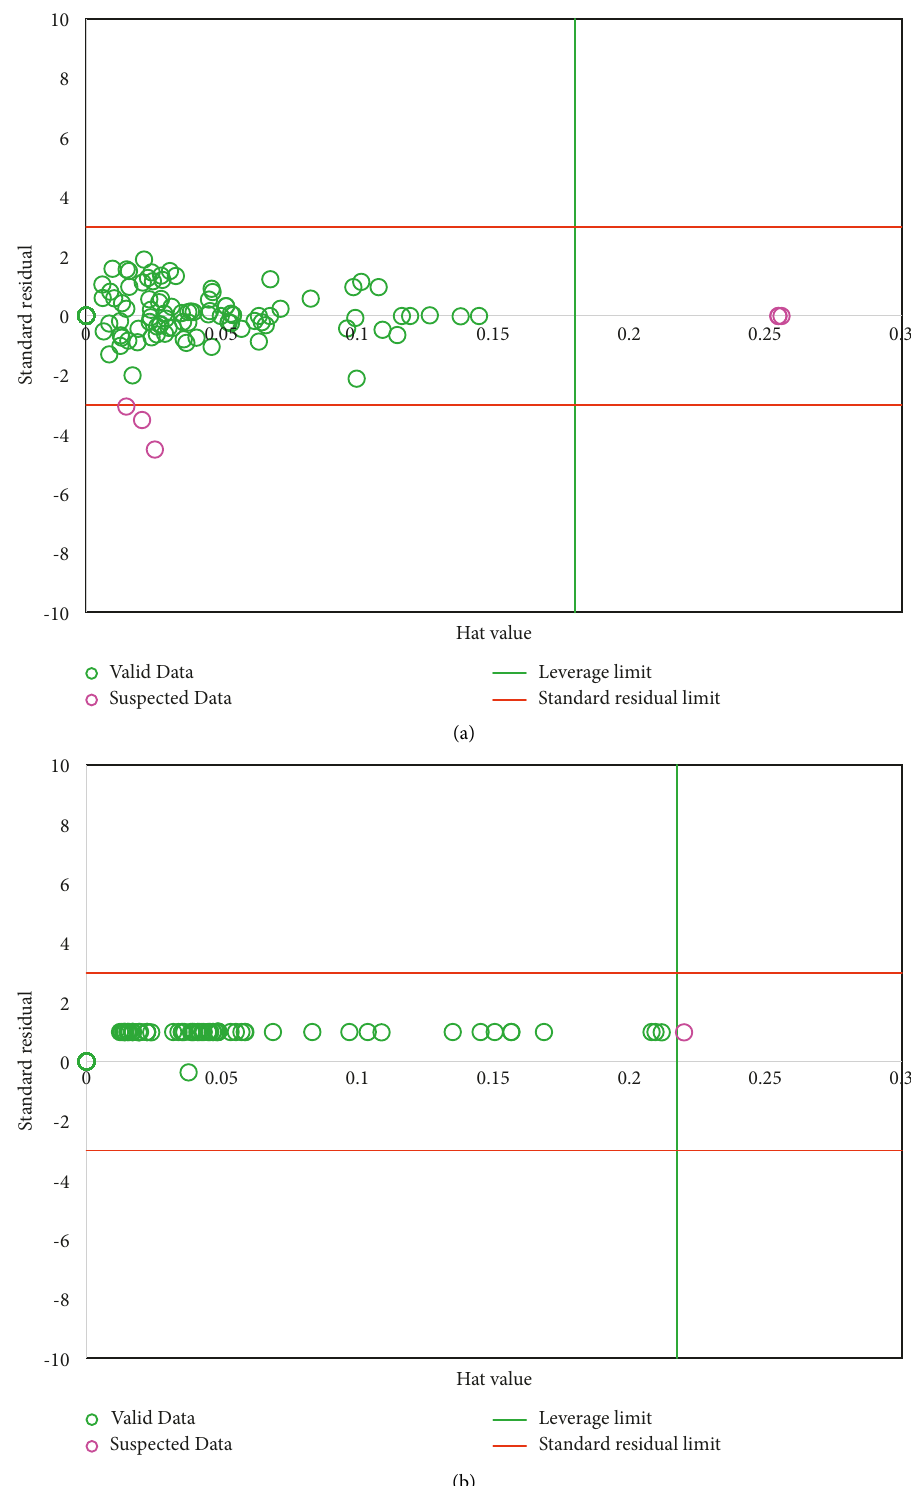
Figure 5: William’s plots for data related to the (a) TC ratio and (b) relative viscosity of